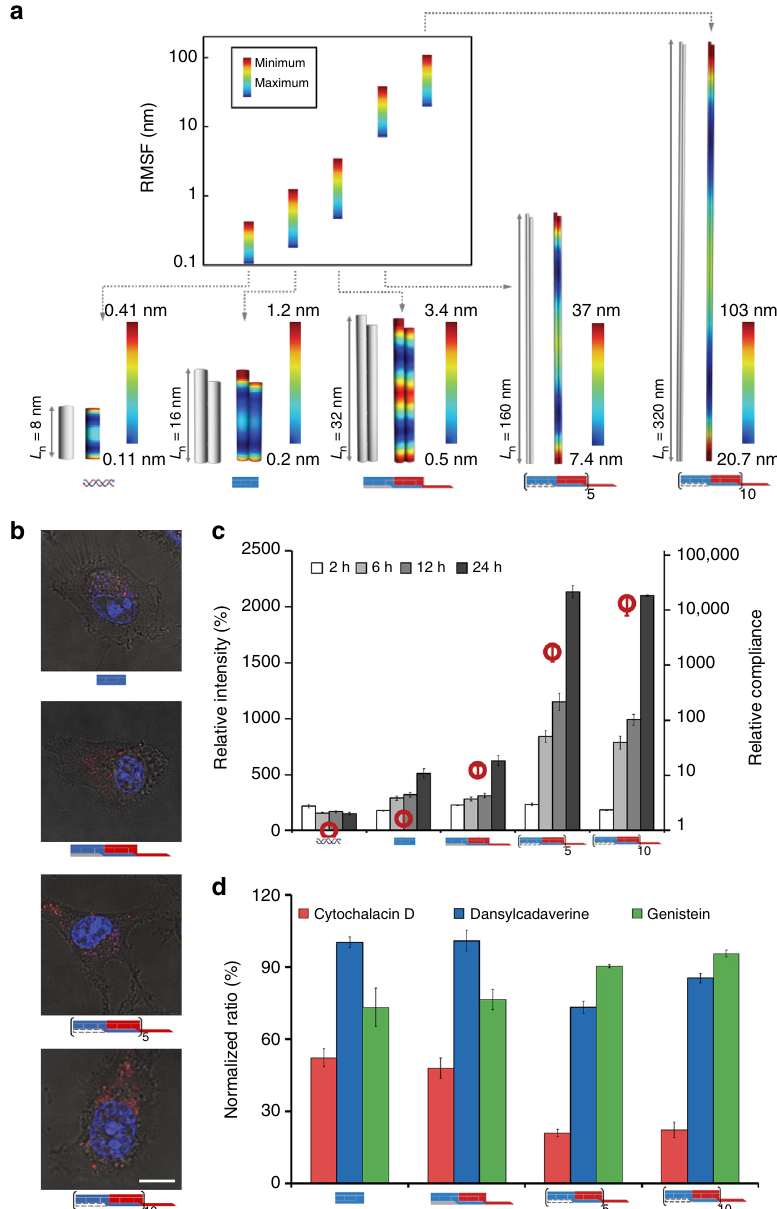
Fig. 5 Endocytosis of 1D DHT nano fi laments in living mammalian cells. a Three-dimensional (3D) equilibrium conformation and heat map color range for root-mean-square fl uctuations (RMSFs) simulated by CanDo. Blue and red color represent low and high relative fl exibility, respectively. Bluest color indicates zero percentile RMSF and reddest color indicates no <95% RMSF. Insets shows plots and table of minimum and maximum RMSF values of double-stranded DNA (dsDNA), monomer A and the nano fi laments of different lengths (i.e., I - A - B , I -[ A - B ] 5 , and I -[ A - B ] 10 ). b Merged confocal images of intracellular localization of Cy3-labeled DNA structures (red) under serum-free incubation condition for 12 h, with cell nuclei stained with SYTO 59 (blue). Scale bars: 10 μ m. c Analysis of the dependence of cellular uptake on the structural properties and time. DNA materials (the concentration was normalized as 50 nM of labeled dyes in dsDNA, monomer A , I-A-B , I -[ A - B ] 5 , and I -[ A - B ] 10 , respectively) were incubated with A549 cells at different time intervals in the serum-free medium. Fluorescence was quanti fi ed with fl ow cytometry. The results are representative of three independent experiments. d Fluorescence analysis of endocytic mechanisms of DHT and DHT nano fi laments. Different endocytosis inhibitors were applied to elucidate the associated mechanisms. All error bars represent the mean ± standard deviation obtained from at least three independent